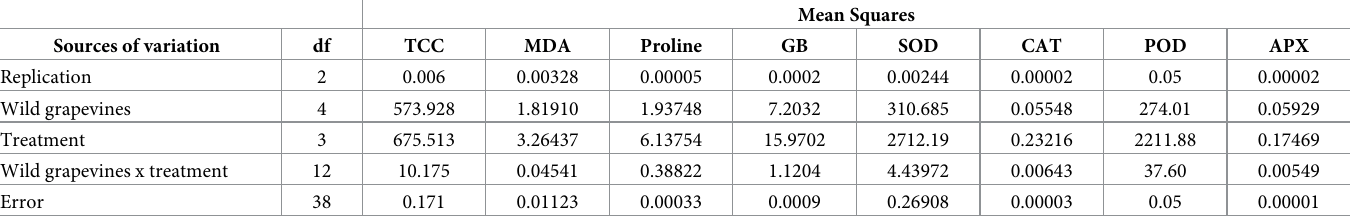
Table 2. Analysis of variance for enzymatic and non-enzymatic biochemical traits of commercial scion variety Flame Seedless grafted on different wild grapevines under drought stress condition.